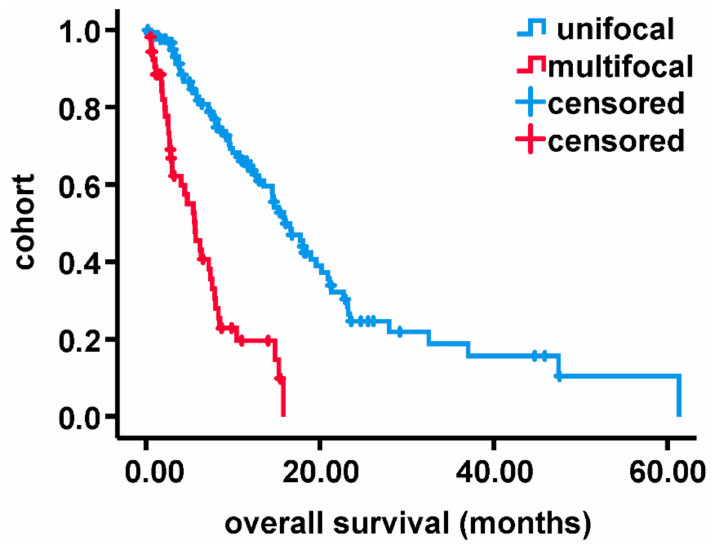
Figure 1. Compared survival of multifocal with unifocal glioblastoma by Kaplan–Meier